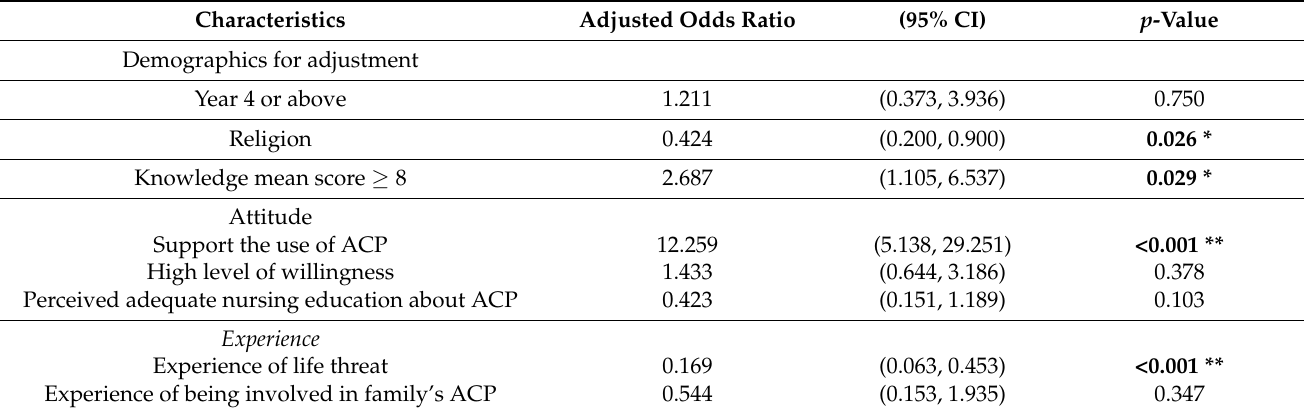
Table 3. Multiple logistic model of nursing students’ role perception, knowledge, attitude, and